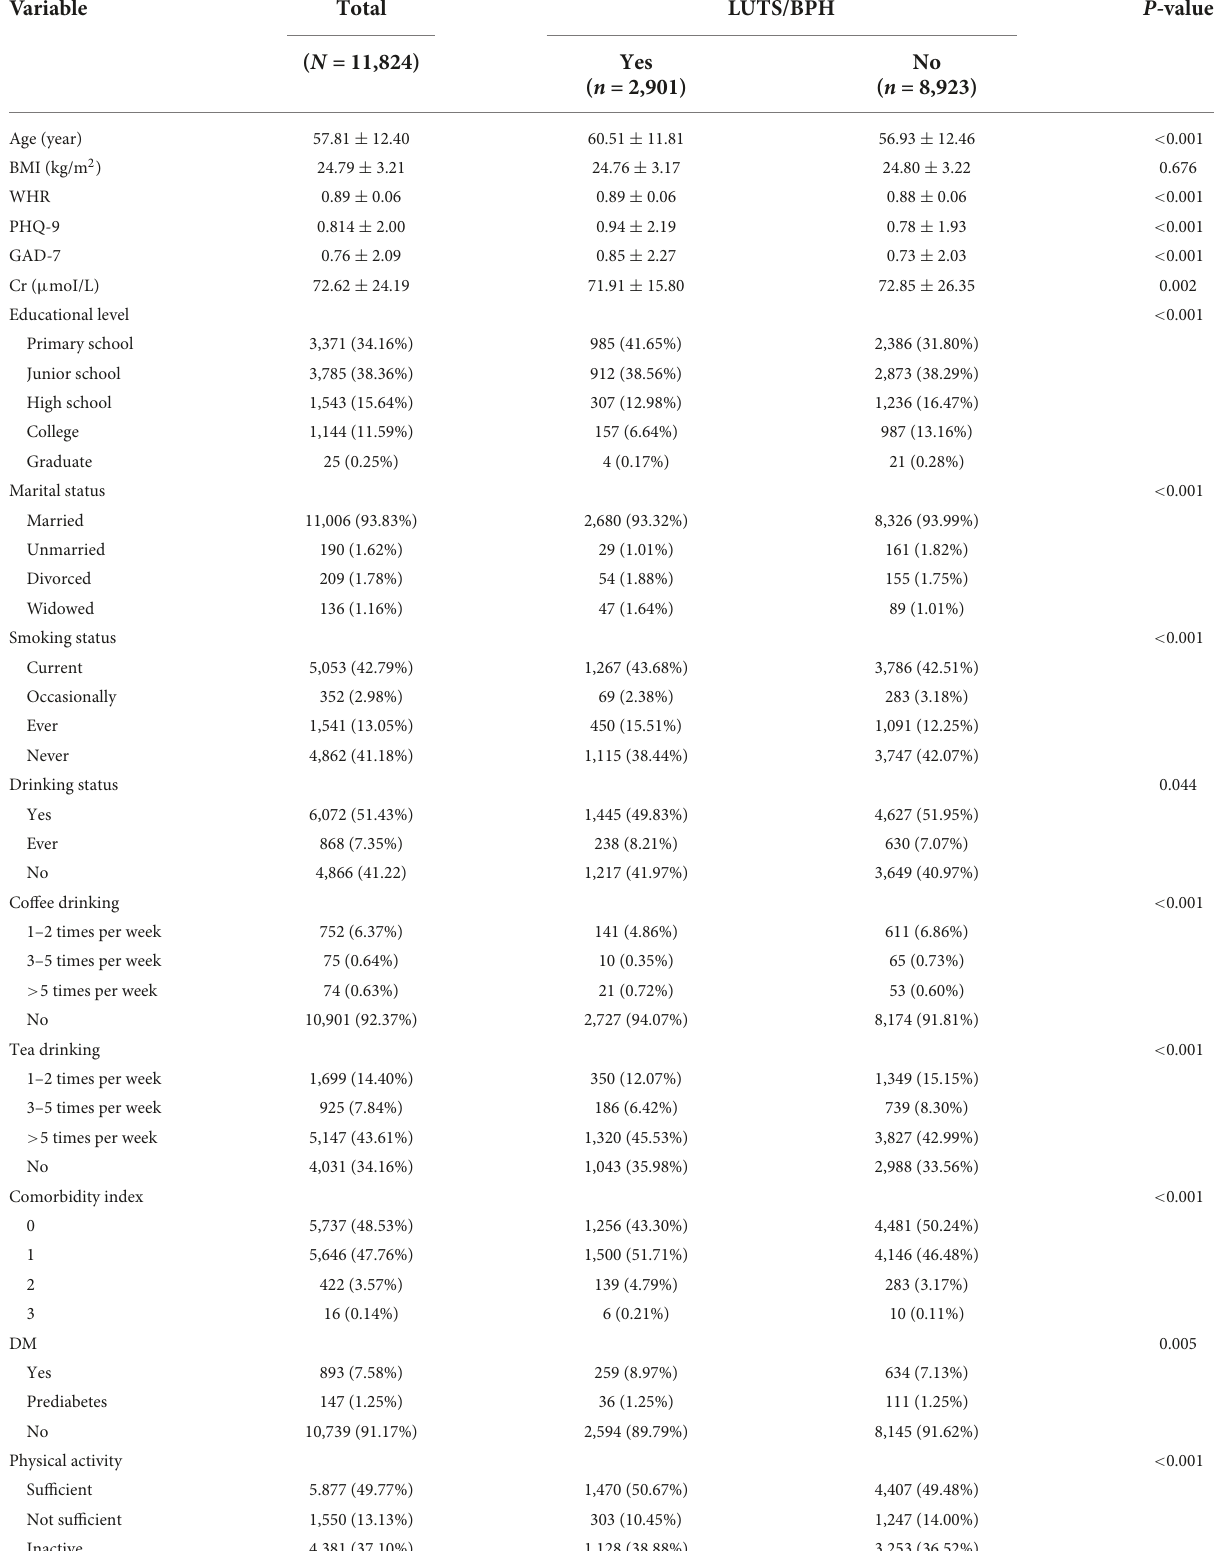
TABLE 1 Baseline characteristics of